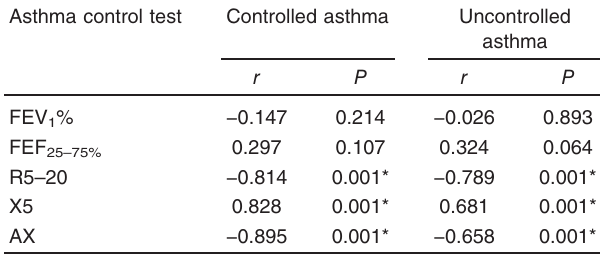
Table 3 Correlation between spirometric, impulse oscillometry parameters, asthma control test in both